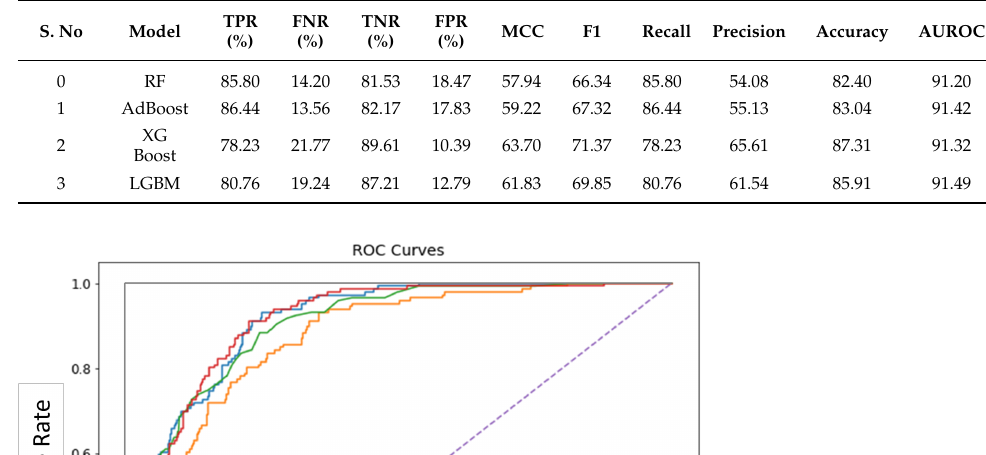
Table 3. ML models performance in estimating strike pipeline suitability.